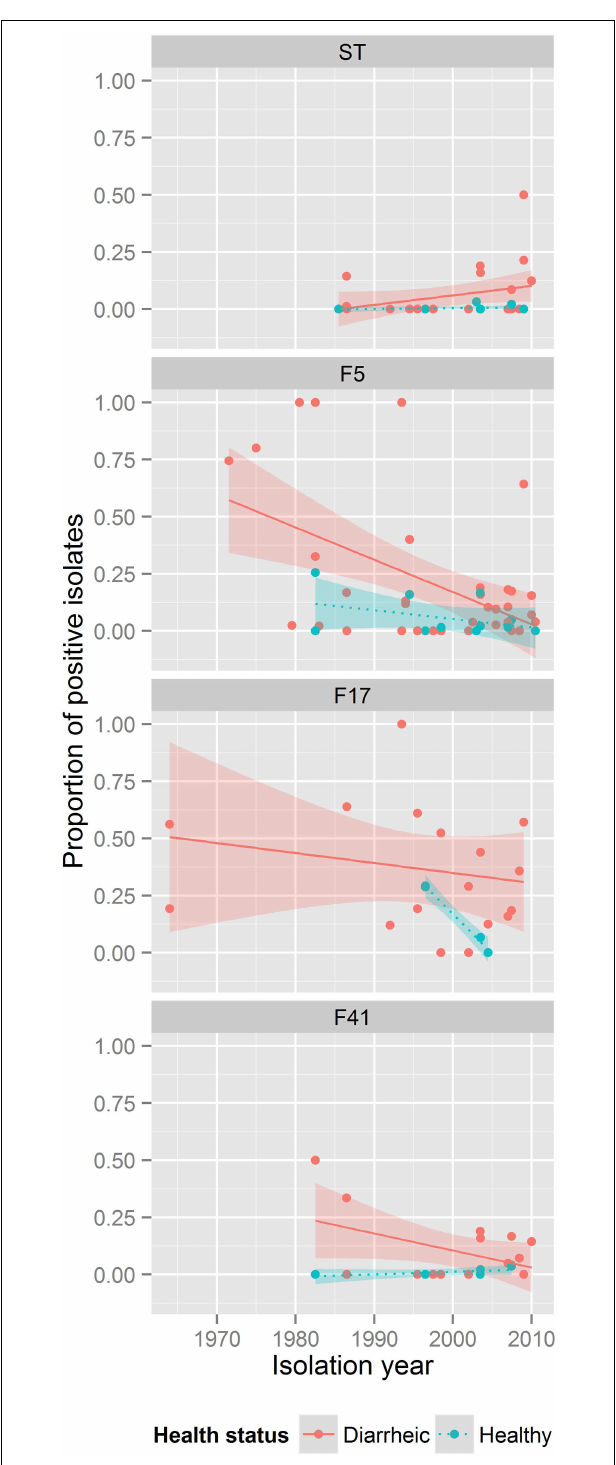
FIGURE 2 | ETEC VAF prevalence in between 1962 and 2013. Each subpanel corresponds to one VAF. The color of dots describes health status of animals: red, diarrheic animals; blue, healthy animals. The lines show general tendencies by approximating the relationship between the year of isolation and the prevalence of a VAF using a linear model y = ax + b. The shaded areas around lines represent confidence